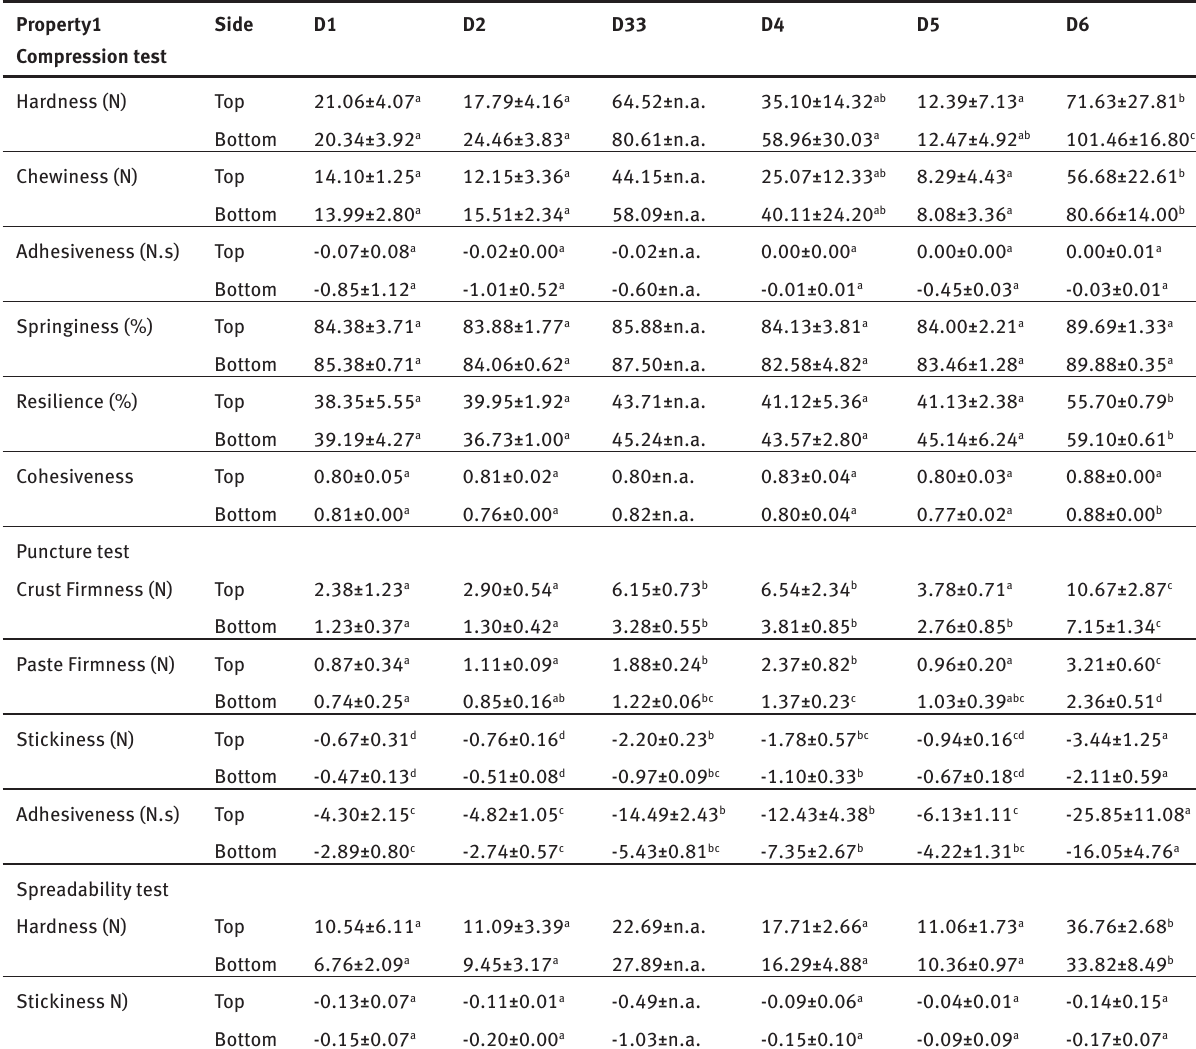
Table 1: Textural properties on top and bottom faces of the cheeses in April (the first moment of evaluation), obtained by the different tests